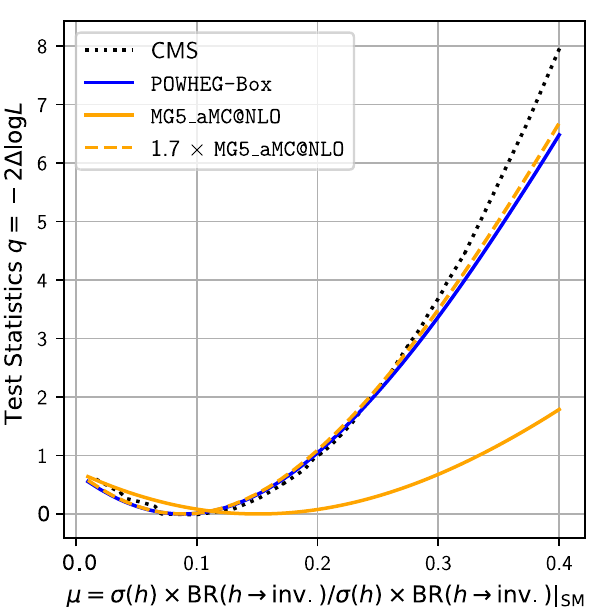
Fig. 1 Comparison of the log-likelihood-ratio, using the numbers in Table 2